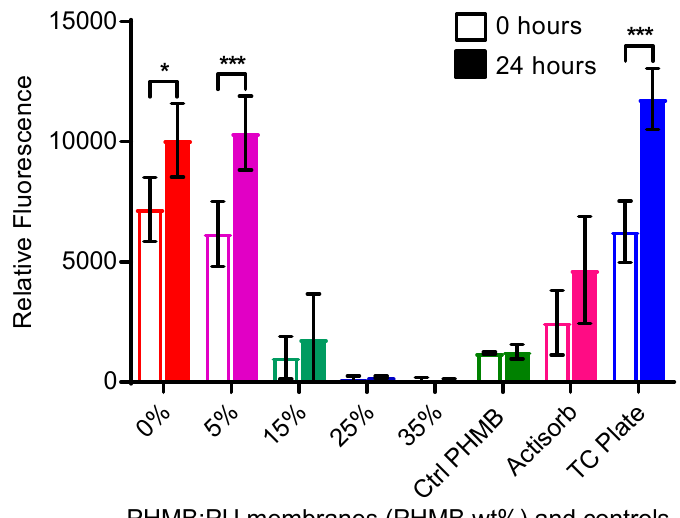
Figure 9. HaCaT cell toxicity. Alamar blue results taken 24 and 48 hours after sample addition. Controls included TC plate (tissue culture plate), paper disks freely infused with PHMB (Ctrl PHMB) and the commercial product Actisorb Silver 220 (Actisorb). Error bars are the standard deviation from the mean, with n = 3. * indicates a significant difference between time points within samples groups (* for p < 0.05 and *** for p < 0.0001 respectively).